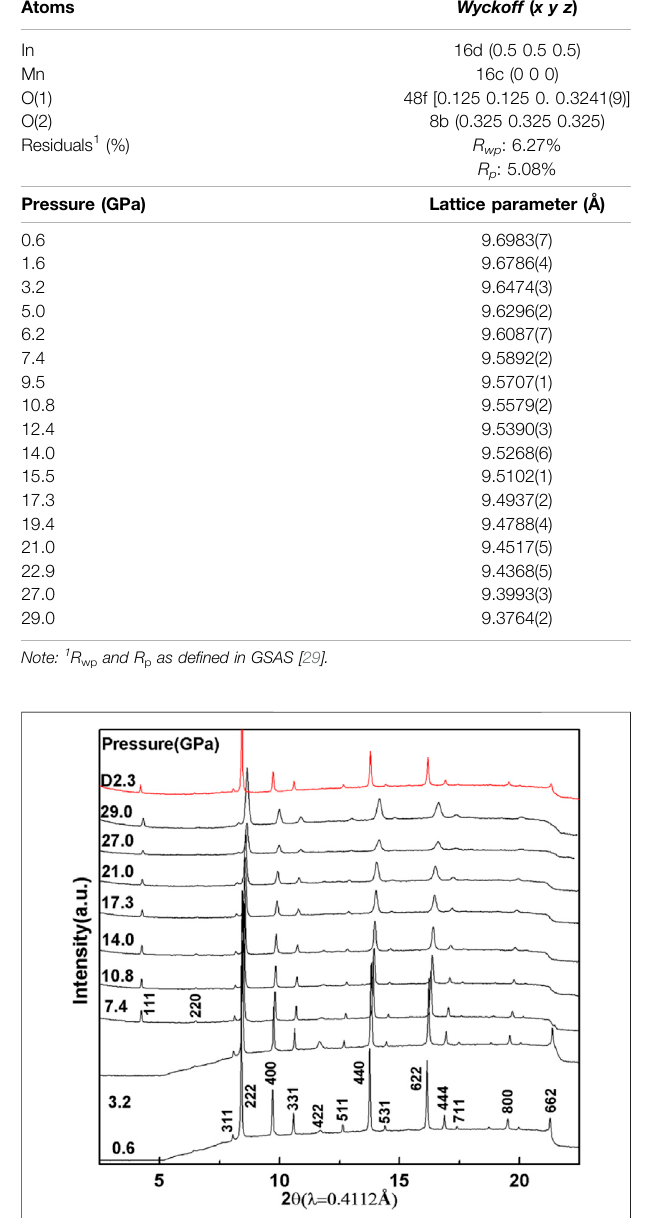
TABLE 1 | Re fi ned atomic coordinates of In 2 Mn 2 O 7 at ambient condition and lattice parameters at various pressures. Atoms